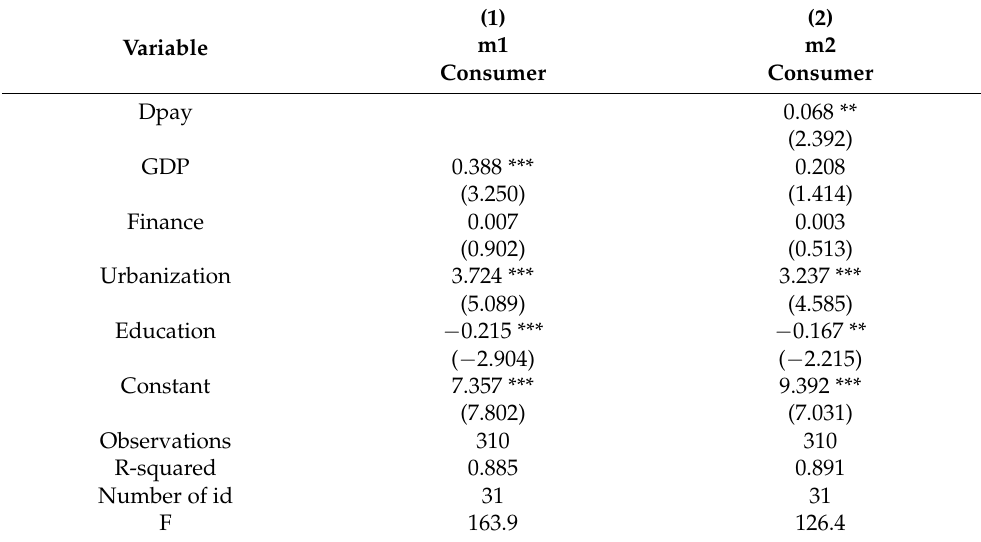
Table 11. Robustness analysis: Robust regression.